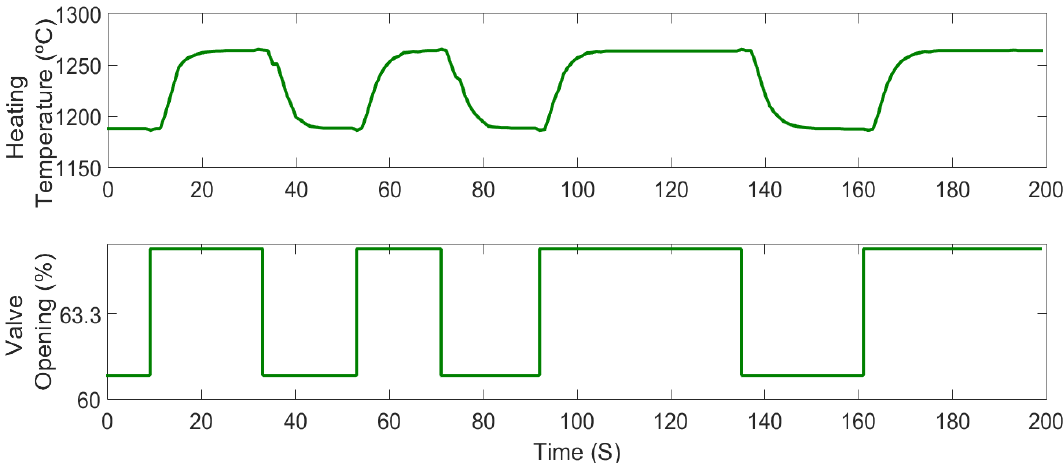
Figure 2. Results of the experiment with a pseudorandom binary sequence (PRBS) signal in the furnace heating zone.